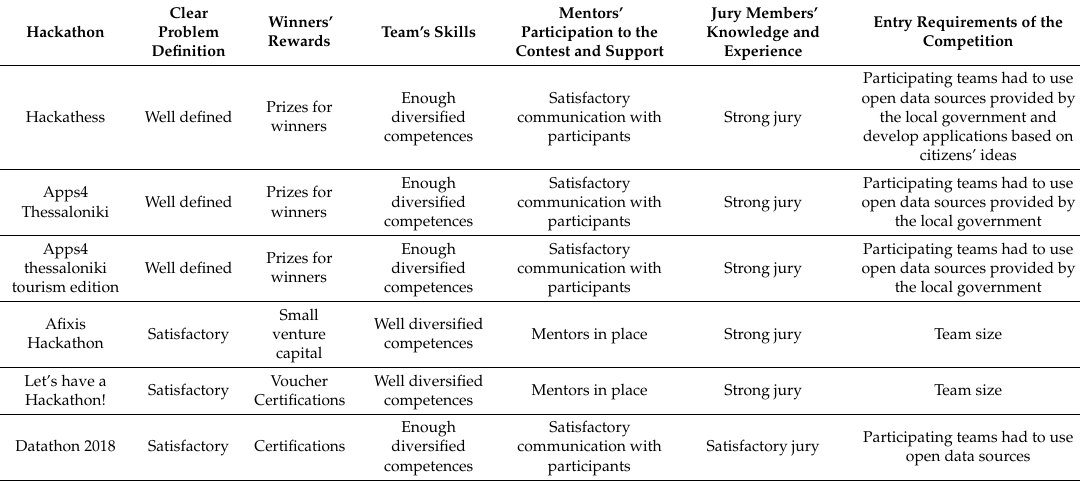
Table 2. The analysis of the six success factors for open data hackathons and digital innovation